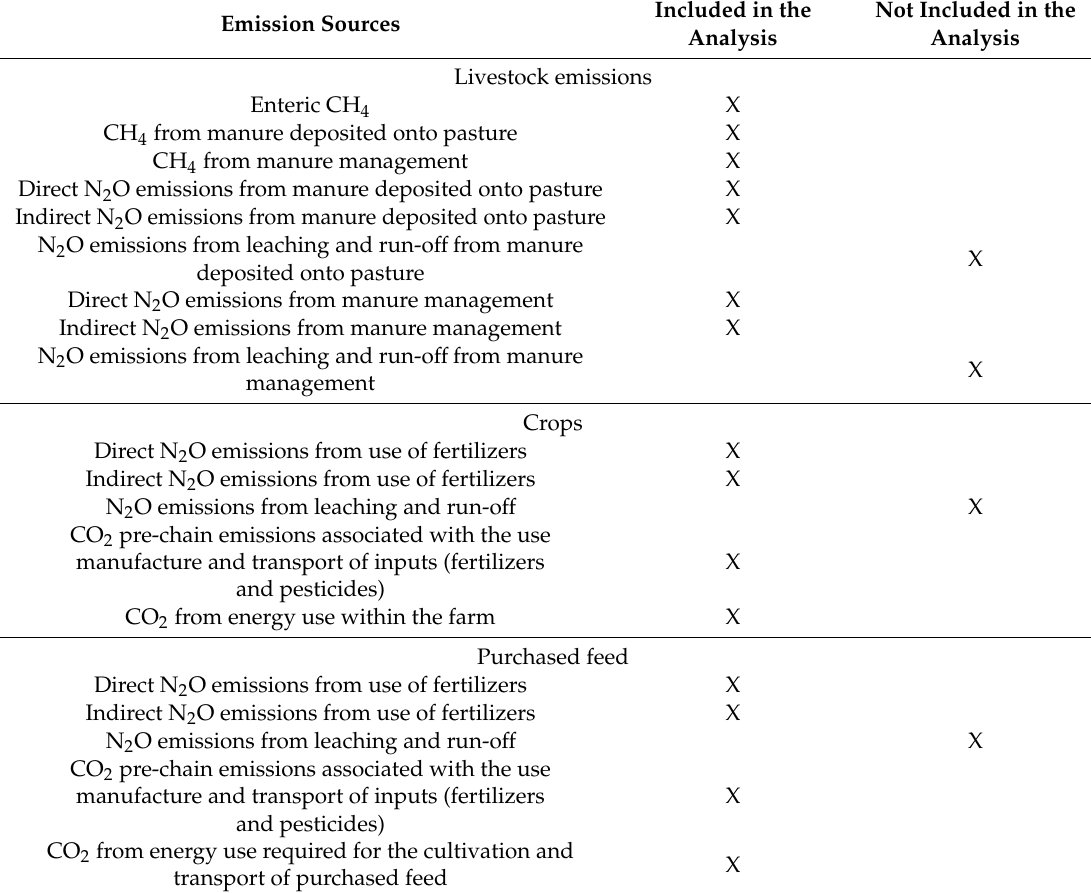
Table 3. Emission sources considered in the